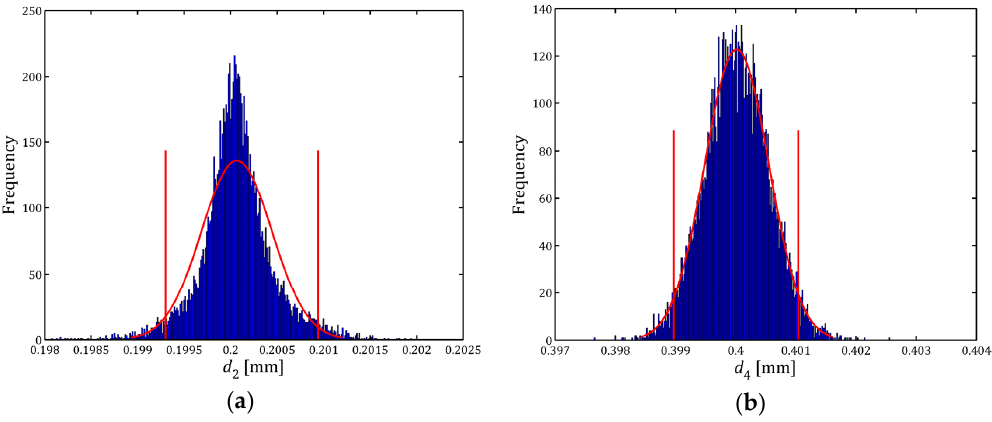
Figure 3. Hypothesis 1. ( a ) d 2 histogram; ( b ) d 4 histogram.